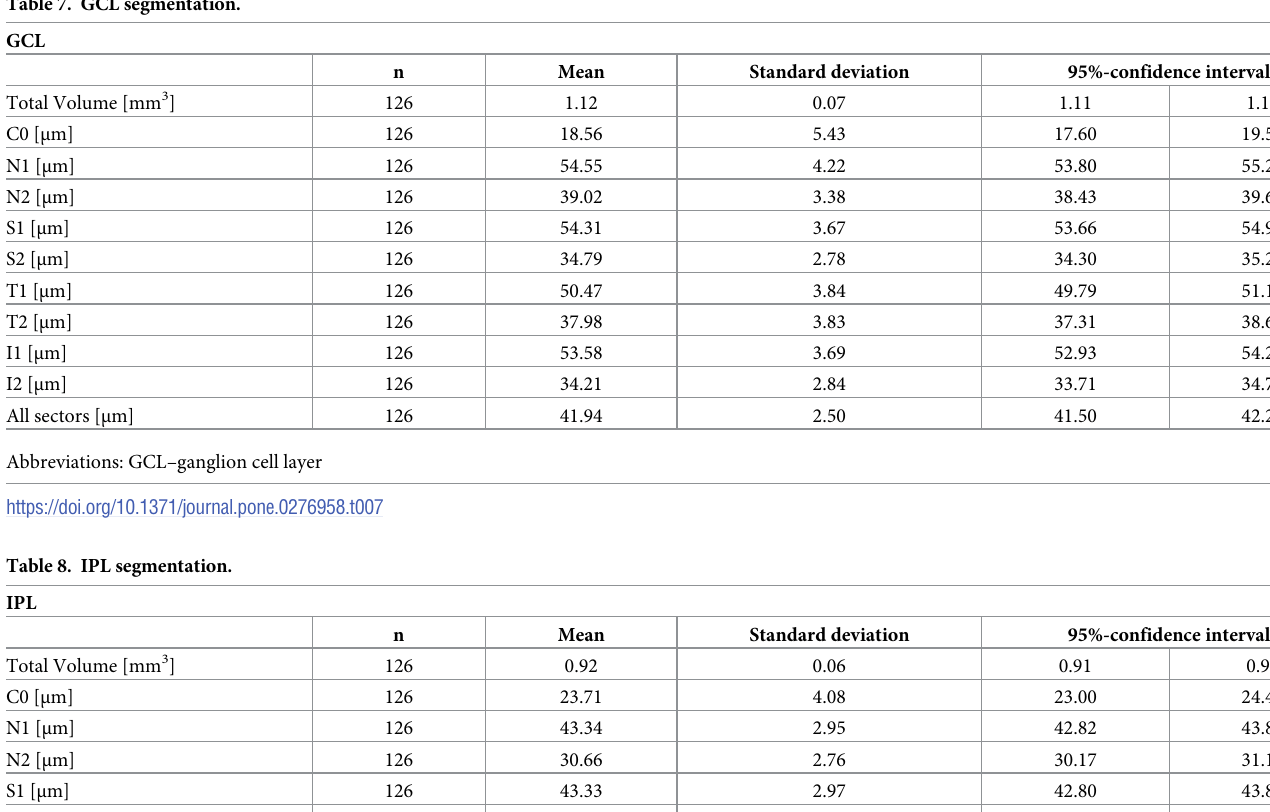
Table 7. GCL segmentation.